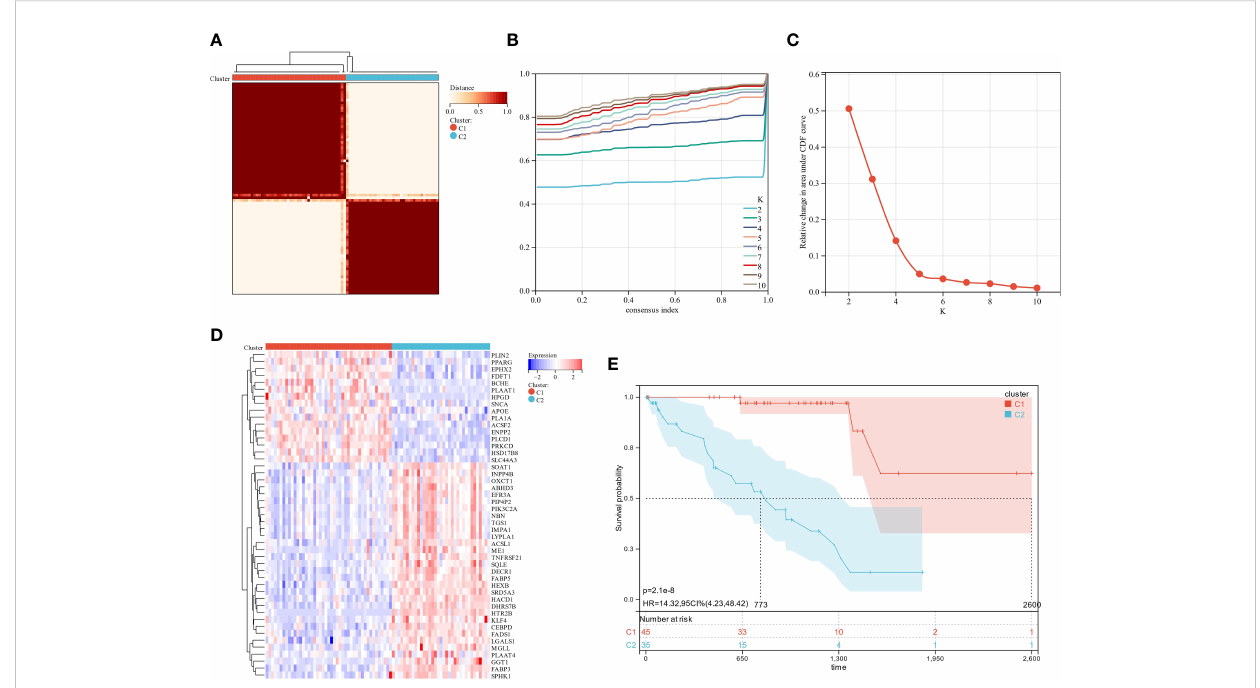
FIGURE 2 The analysis of consensus clustering. (A – C) Consensus clustering is best performed with K = 2. (D) A heatmap illustrating the differential expression of lipid metabolism genes between the two groups. (E) Two subgroups of patients displayed different survival